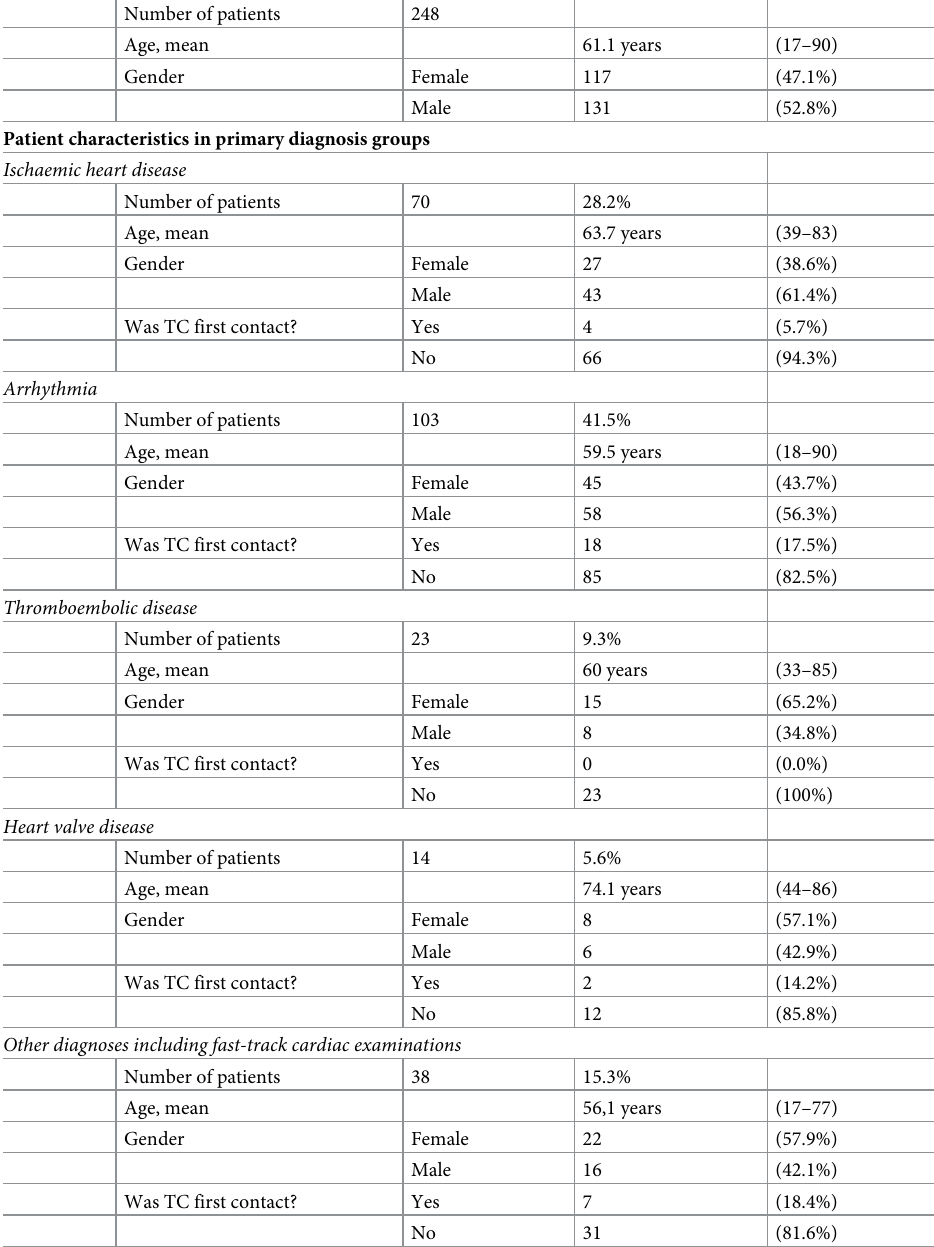
Table 2. Patient characteristics, quantitative study. Patient